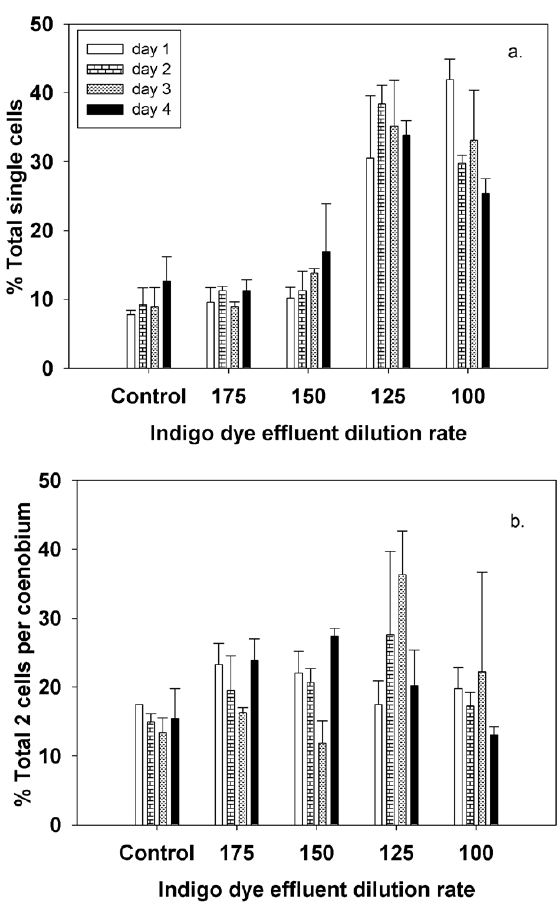
Fig. 5 - Percentage of total of 3 cells per coenobium (a) and 4 cells per coenobium (b) of Scenedesmus quadricauda as a function of different indigo dye effluent